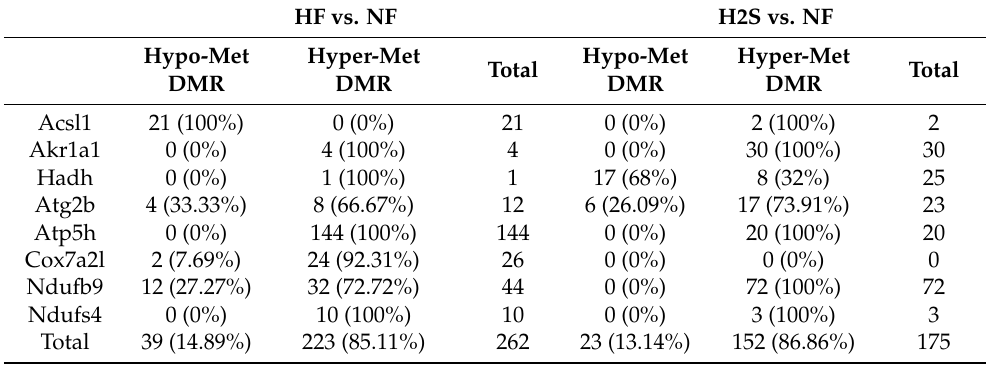
Table 2. Summary of DMRs by HF and H2S diets.